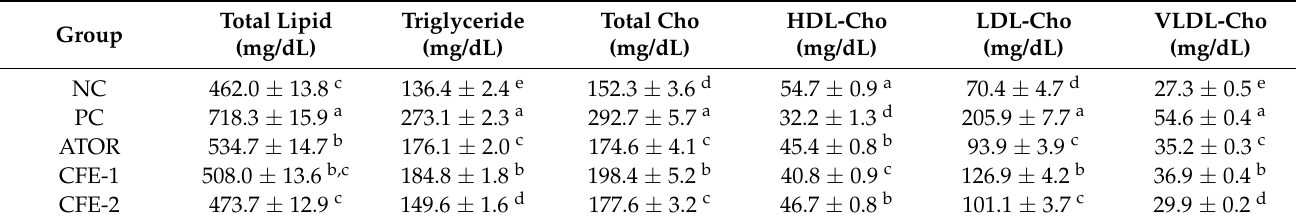
Total Cho: Total cholesterol. HDL-Cho: High-density lipoprotein cholesterol. LDL-Cho: Low-density lipoprotein cholesterol. VLDL-Cho: Very low-density lipoprotein cholesterol. NC: Negative control. PC: High-fat diet. ATOR: High-fat diet + atorvastatin 10 mg/kg body weight/day. CFE-1: High-fat diet + lipase crude extract 100 mg/kg body weight/day. CFE-2: High-fat diet + lipase crude extract 200 mg/kg body weight/day. Values are presented as mean ± SD ( n = 8). Mean values within the same column with different superscripts letters are significantly different ( p < 0.05). A total of 40 animals were divided into five groups (8 animals each). Postbiotic is the cell-free extract